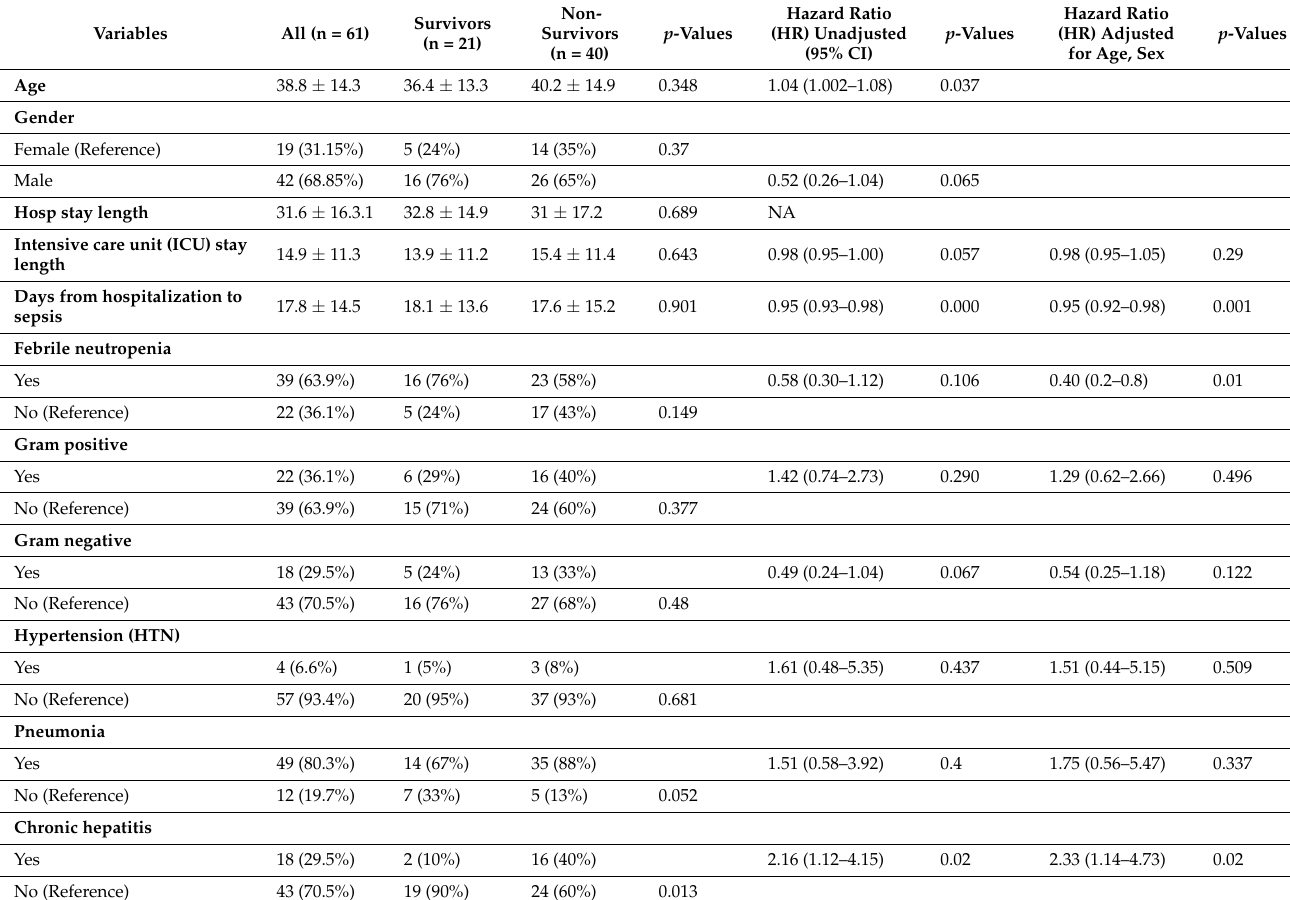
Table 1. Patient characteristics, comorbidities, and